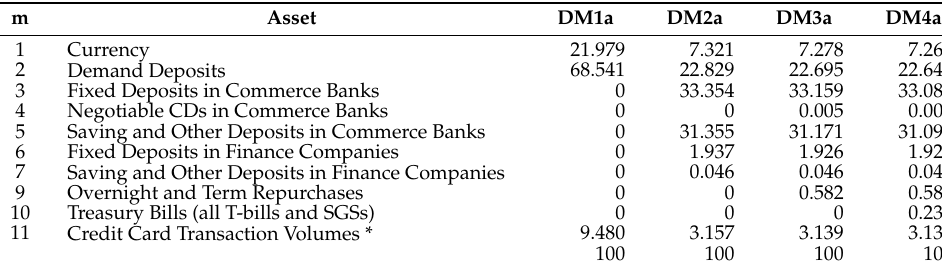
Table 5. Credit-Card-Augmented Growth-rate Weights (Jun 2019),